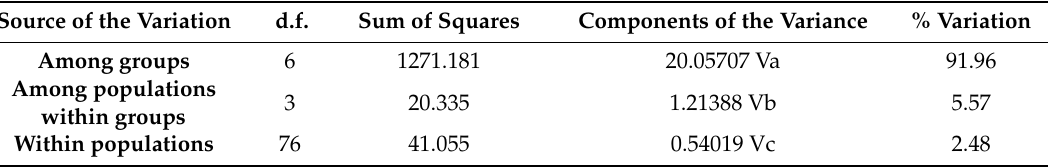
Table 2. Analysis of Molecular Variance (AMOVA) of the samples of Brycon pesu